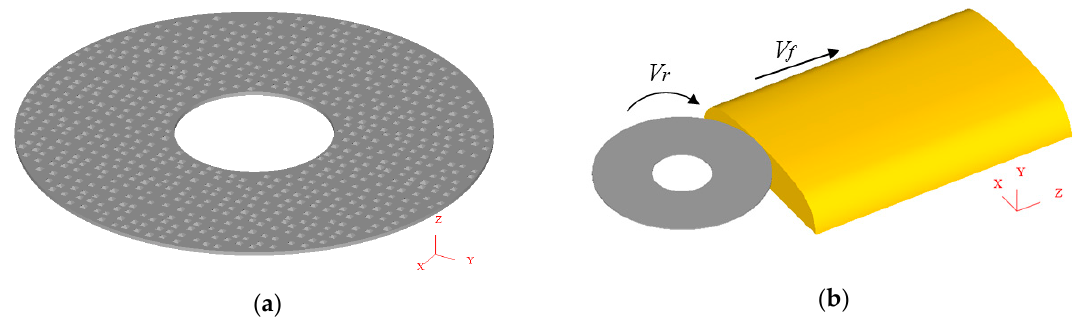
Figure 2. 3D model of rail grinding in the field showing ( a ) the grinding wheel and ( b ) rail